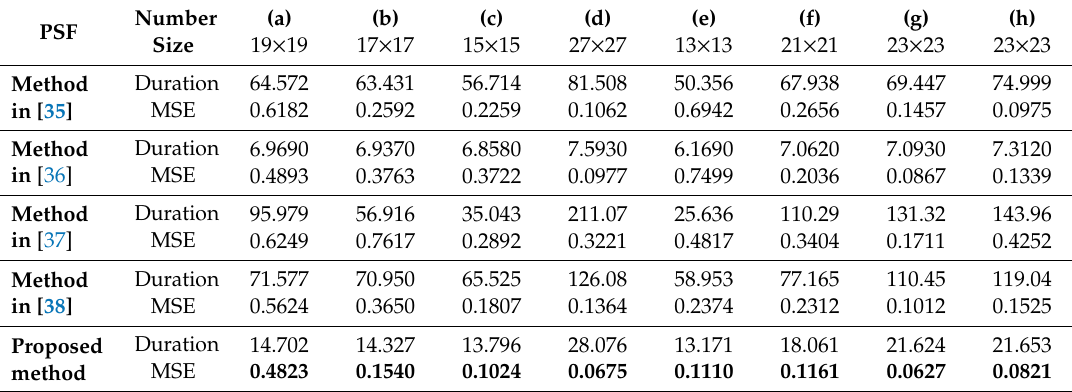
Table 1. Comparison results of the blur kernel estimation. The cost durations are recorded in seconds, and the best results of mean square error (MSE) are shown in